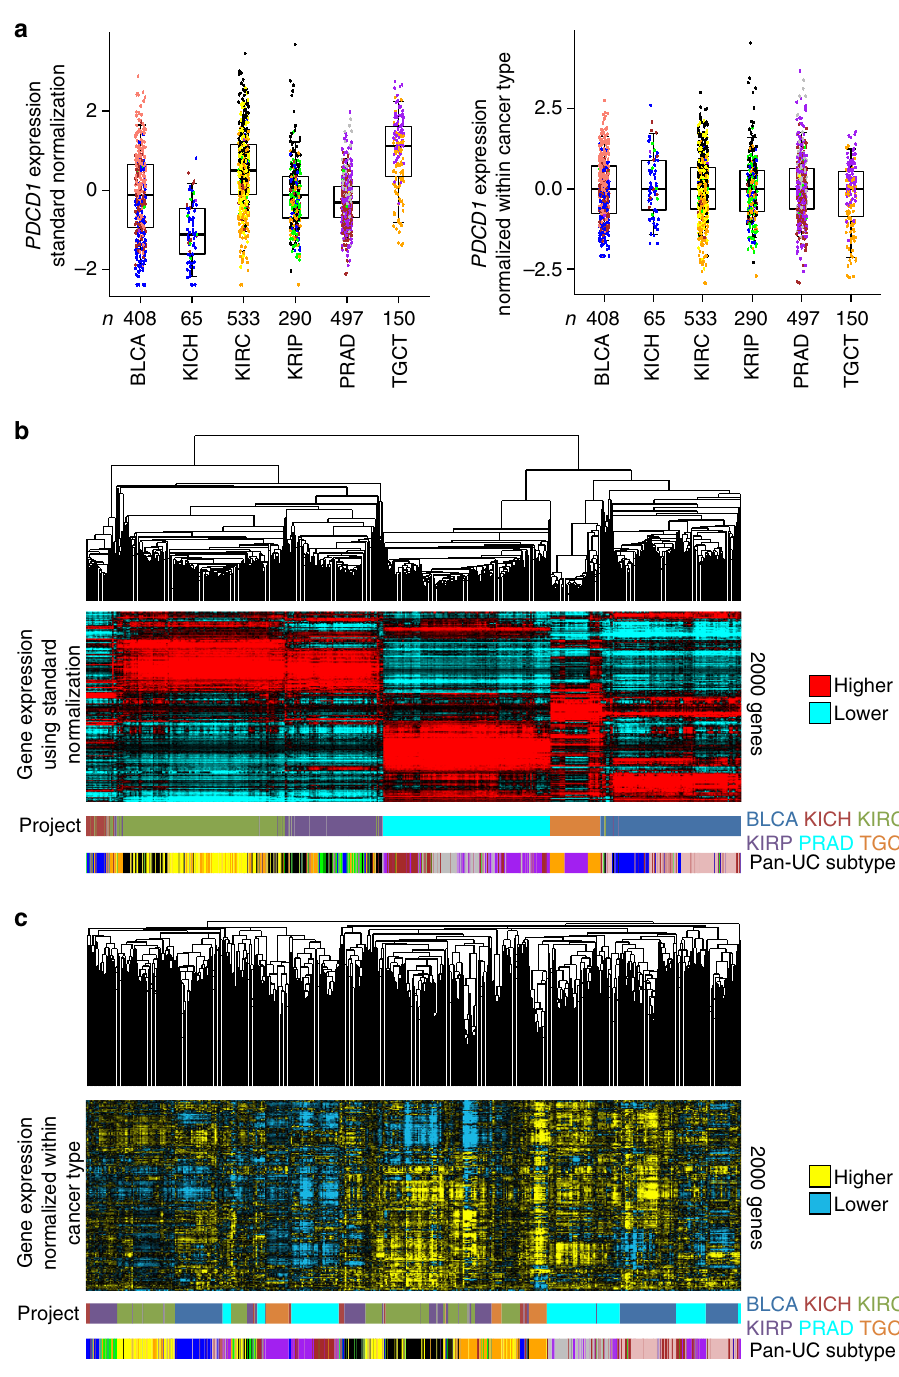
Fig. 1 Alternative classi fi cation approach de fi nes cancer subtypes that transcend tissue-of-origin. a Expression patterns of a representative marker ( PDCD1 ) that distinguishes between both cancer type and genomic subtype across TCGA BLCA, KICH, KIRC, KIRP, PRAD, and TGCT cancers. Left , PDCD1 expression, with values normalized using a “ standard ” approach (s.d. from the median across all cancers); right , PDCD1 expression, with values normalized within each cancer type (giving the values within each cancer type shown a median of zero and s.d. of one). Box plots represent 5%, 25%, 50%, 75%, and 95%. b Unsupervised hierarchical clustering of TCGA urologic cancer cases ( n = 1944), where expression values have standard normalization. The top 2000 most variable genes in the pan-urologic cancer data set were used in the clustering. TCGA project designation and pan-urologic cancer genomic subtype are indicated (described in Fig. 2). c Similar to part b, but using expression values normalized within each cancer type. The same genes from part b were used to carry out the clustering in part c . TCGA project designation: BLCA, Bladder Urothelial Carcinoma; KICH, Kidney Chromophobe; KIRC, Kidney renal clear cell carcinoma; KIRP, Kidney renal papillary cell carcinoma; PRAD, Prostate adenocarcinoma; TGCT, Testicular Germ Cell different molecular platforms were combined by a “ cluster of The nine genomic subtypes of TCGA urologic cancers (Table 1) clusters analysis ” (COCA) 7, 10, 16 approach (Fig. 2a) to form nine included: a c1 subtype ( n = 216 cases) of predominantly BLCA, different integrated subtypes (Supplementary Fig. 1c – e), referred KICH, and KIRP cases (comprising 56%, 23%, and 19% of these to here as “ c1 ” through “ c9 ” . cases, respectively); a c2 subtype ( n = 333) of predominantly